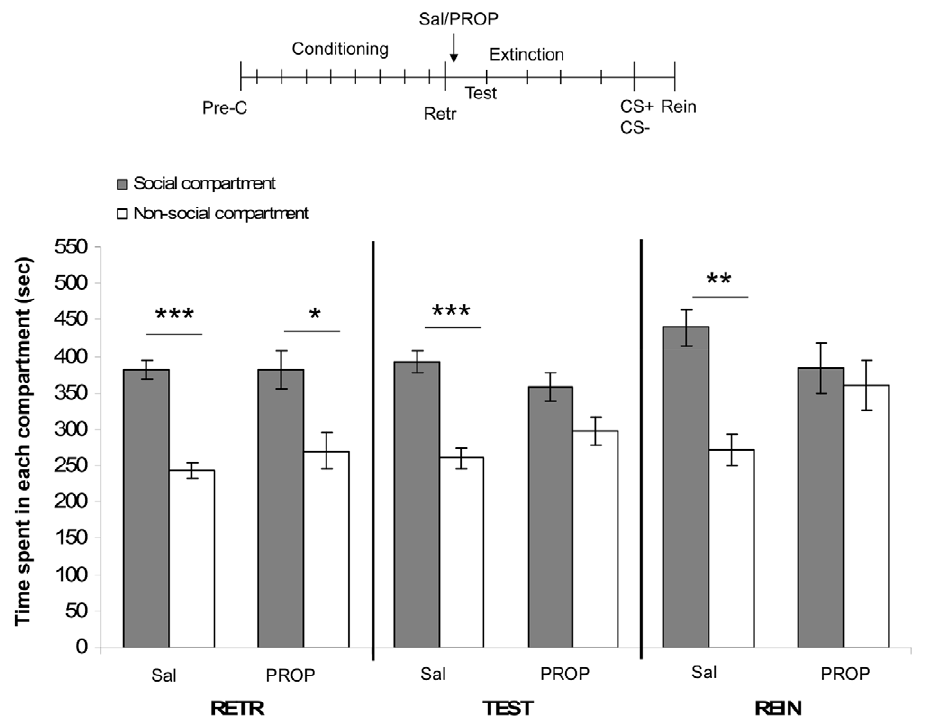
Figure 1. Effects of acute post-retrieval PROP on social play-induced CPP. The experimental protocol is depicted above the graph (Pre-C: pre-conditioning test, CS + : conditioning session with a play-partner, CS-: conditioning session alone). Data represent the mean time (sec 6 SEM) spent in the social compartment (grey bars) and the non-social compartment (white bars) during 15 min retrieval- (RETR), test- (TEST) and reinstatement- (REIN) sessions. Saline-treated animals (2 ml/kg, i.p. , n=18), PROP-treated animals (10 mg/kg, i.p. , n=8). Post-hoc Student’s paired t- tests for difference in time spent in the social- and non-social compartment *p , 0.05, **p , 0.01, ***p , 0.001.